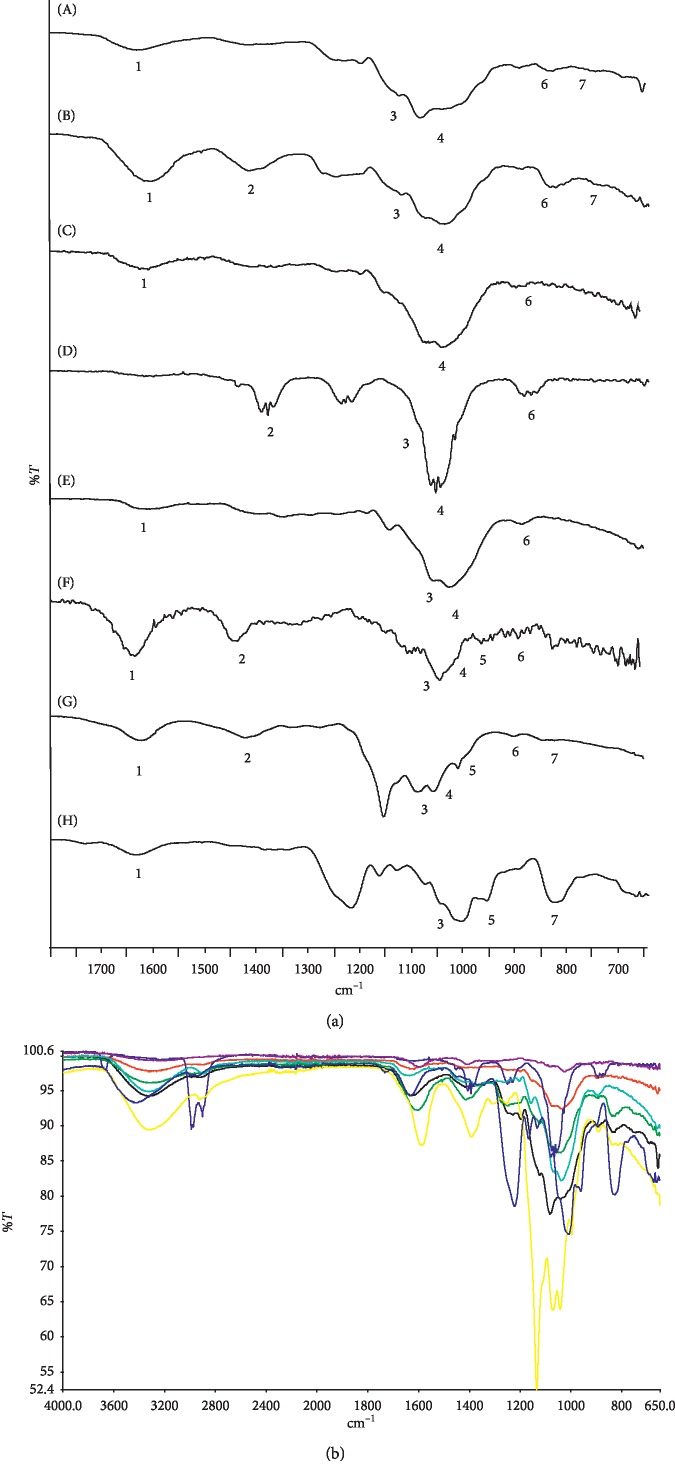
(a) ATR-FT-IR spectra of seaweed extract samples and polysaccharide standards: (A) Cystoceira osmundacea, (B) Silvetia compressa, (C) Pterygophora californica, (D) Egregia menziessi, (E) Ecklonia arborea, (F) sodium alginate, (G) laminarin, and (H) fucoidan. Numbers 1 to 7 in FTIR spectra indicate most characteristic bands. (b) ATR-FT-IR spectrum of experimental seaweed extracts, sodium alginate, laminarin, and fucoidan standards: C. osmundacea seaweed extract (black line); S. compressa seaweed extract (green line); P. californica seaweed extract (red line); E. menziesii seaweed extract (royal blue line); E. arborea seaweed extract (aqua line); sodium alginate standard (purple line); laminarin standard (yellow line); fucoidan standard (navy line).